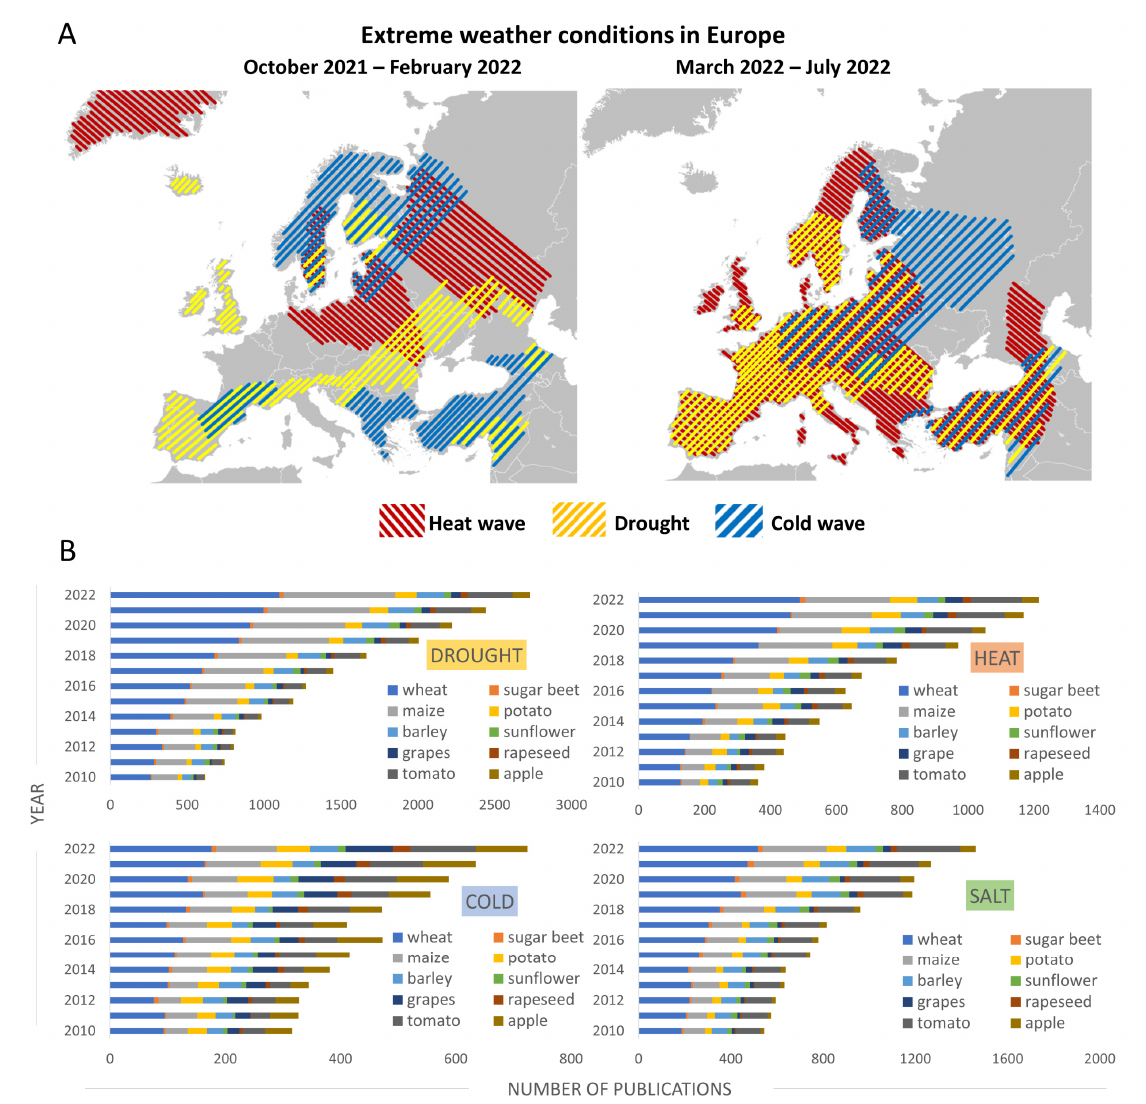
Figure 1. Locations of recorded extreme weather conditions in Europe and the number of published works focusing on abiotic stress in crops. ( A ) Weather conditions recorded by the German Weather Service from October 2021 to February 2022 and March 2022 to July 2022 (Deutscher Wetterdienst, 2022, [15]). The heat or cold wave is a period of at least one week with temperature anomalies (ex- ceeding +6 ◦ C over or − 6 ◦ C below the average temperature during the reference period 1981–2010). Panel 1A was adapted from an original map image made by Maix, Wikimedia Commons, distributed under a CC SA 3.0 License. ( B ) The number of publications focusing on a specific crop and abiotic stress in the last 13 years. The data were obtained from the Clarivate Web of Science database based on the methodology detailed in Supplementary Materials